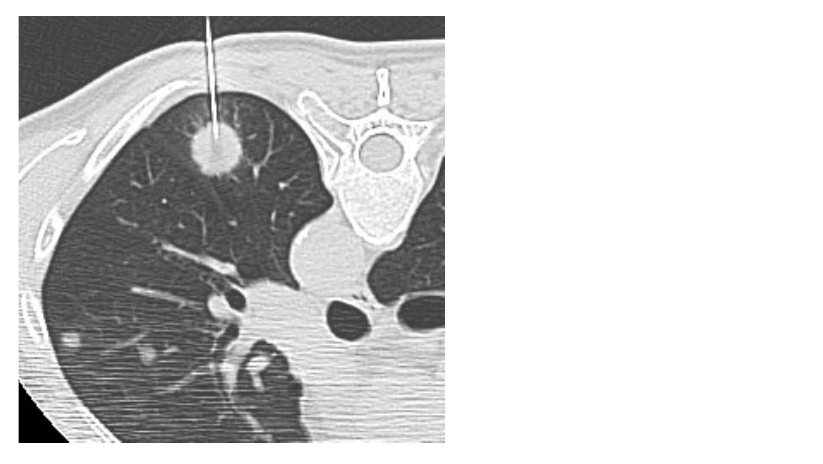
Figure 1. CT ‐ guided biopsy of a solid pulmonary lesion in the left lower lobe. Supine unenhanced Figure 1. CT-guided biopsy of a solid pulmonary lesion in the left lower lobe. Supine CT scan obtained before sampling shows a satisfactory position of the needle tip within the lesion.